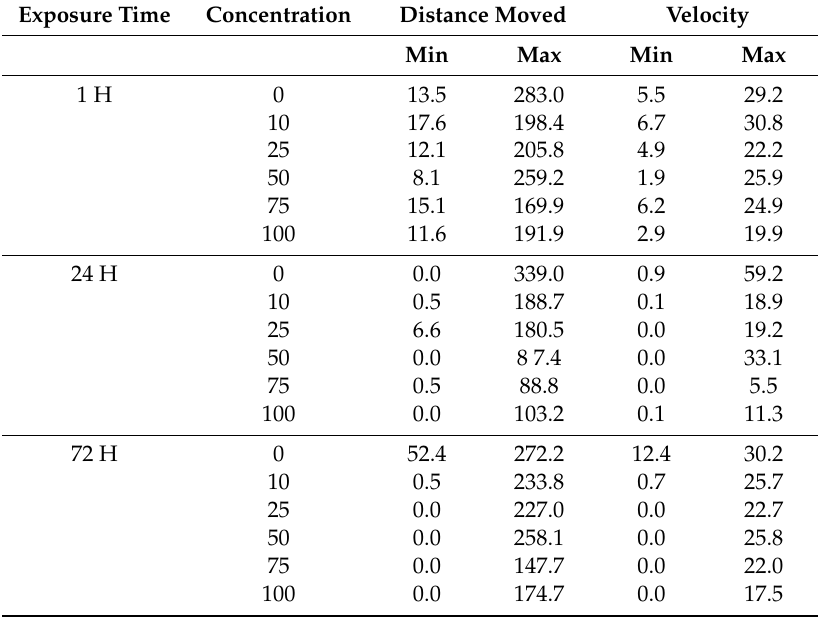
Table 4. Minimum (Min) and maximum (Max) values for total distance moved (in cm) and instantaneous velocity (Velocity, cm / min) for S. oryzae during 10 min trials after 1, 24, and 72 h of exposure to the combination treatment of deltamethrin + methoprene + piperonyl butoxide synergist, with a total of n = 15 individuals tested per treatment